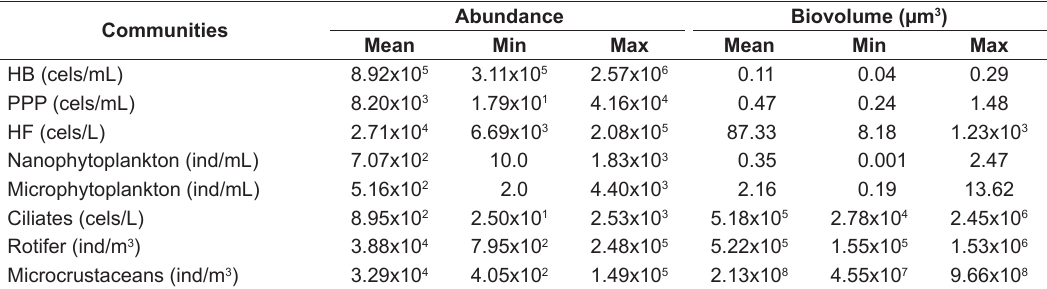
Table 1. Mean, minimum and maximum values of abundance and biovolume of each community. Communities